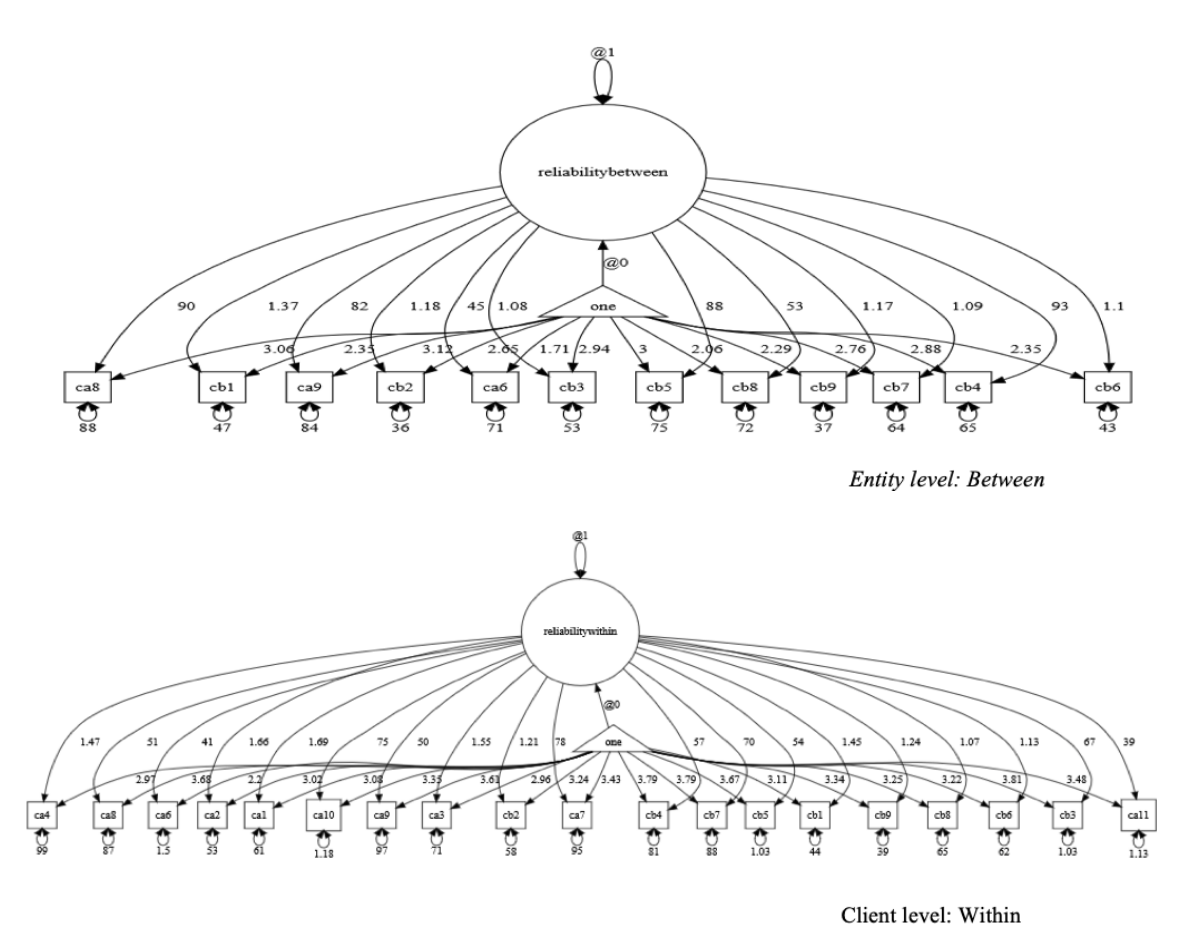
Figure 1: Path diagram showing the measurement of Service